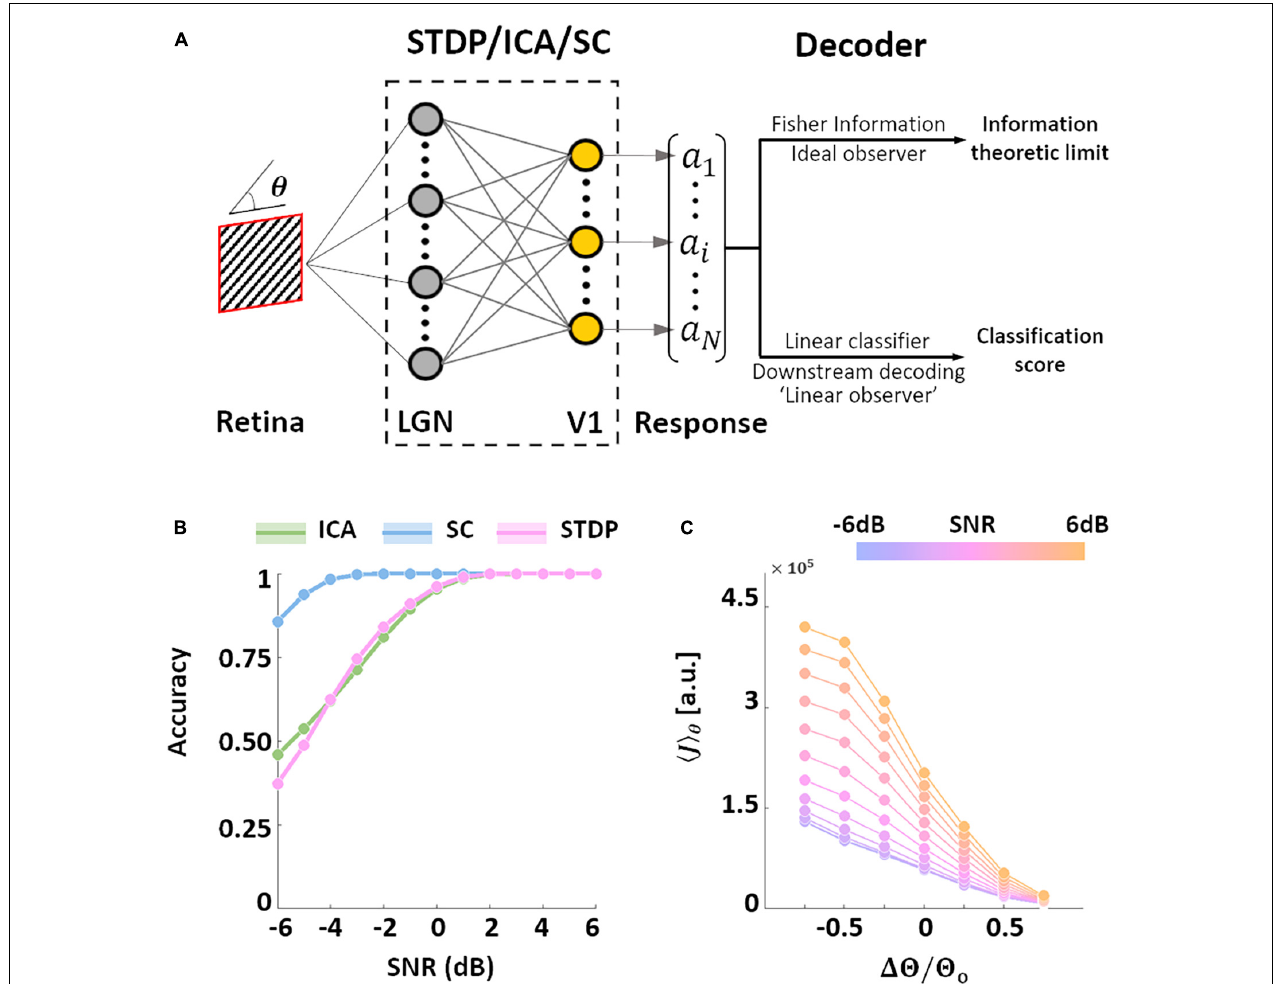
FIGURE 4 | Orientation decoding. (A) Retrieving encoded information. Sine-wave gratings (SWGs) with varying degrees of additive Gaussian noise were presented to the three models. The following question was then posed: how much information about the stimulus (in this case, the orientation) can be decoded from the population responses? The theoretical limit of the accuracy of such a decoder can be approximated by estimating the Fisher information (FI) in the responses. In addition, a linear decoder was also used to directly decode the population responses. This could be a downstream process which is linearly driven by the population activity, or a less-than-optimal “linear observer.” (B) Linear decoding. The responses of each model were used to train a linear-discriminant classifier. The ordinate shows the accuracy (probability of correct classification) for each level of added noise (abscissa). Results for ICA are shown in green, SC in blue, and STDP in pink. (C) Post-training threshold variation in STDP. The SWG stimuli were also used to test STDP models with different values of the threshold parameter. The threshold was either increased (by 25, 50, or 75%) or decreased (by 25, 50, or 75%) with respect to the training threshold (denoted by θ o ). The abscissa denotes the relative change in threshold, and the ordinate denotes the estimated FI. The colour of the lines denotes the input SNR, which ranged from − 6 dB (blue) to 6 dB (orange).